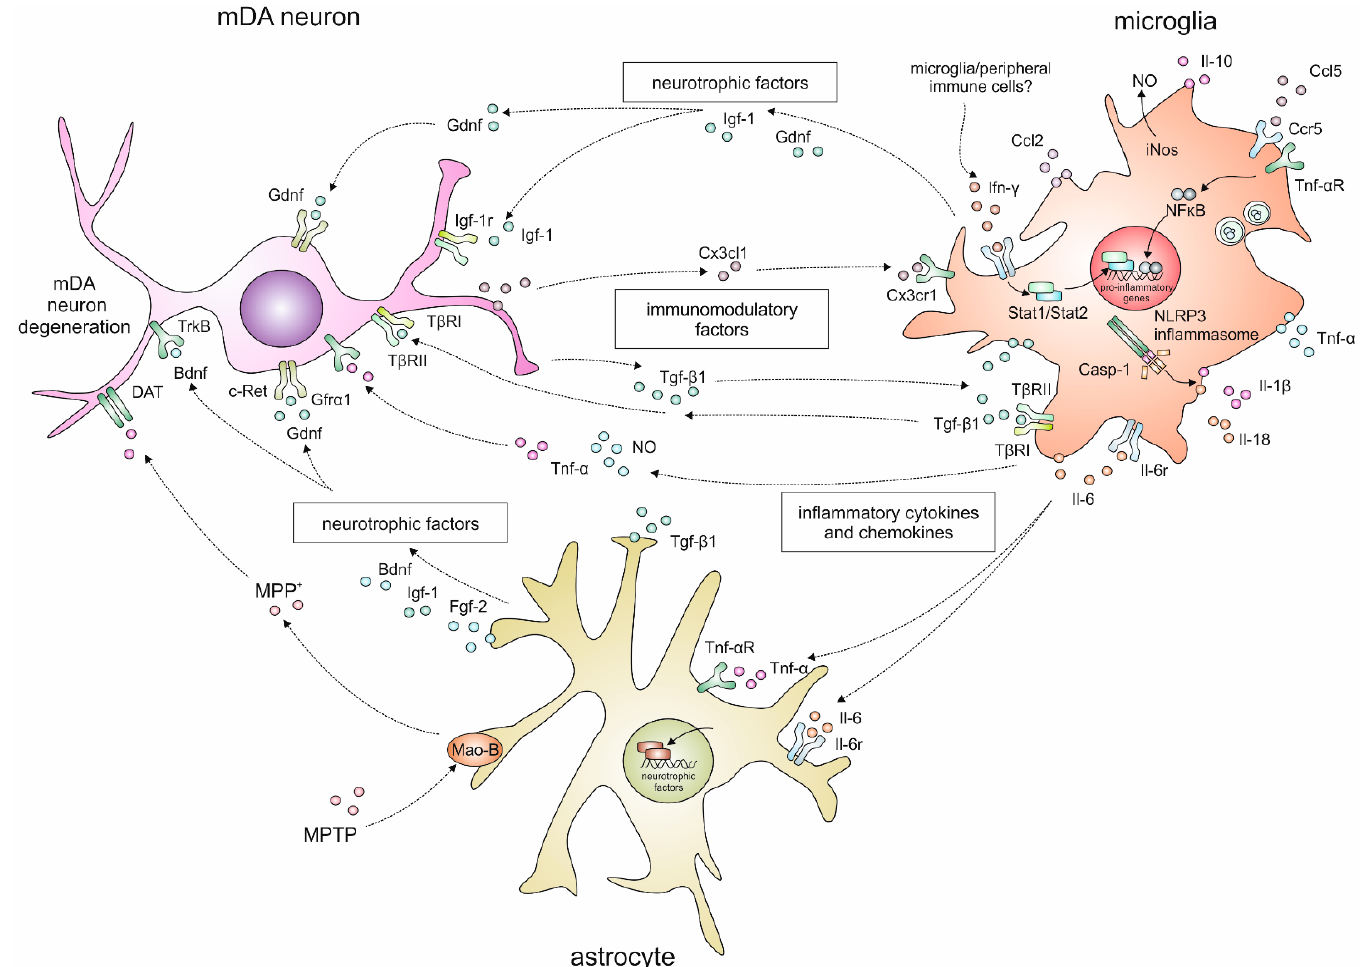
Figure 1. Schematic overview of the complex interactions between mDA neurons, microglia and astroglia after MPTP applications in mice.